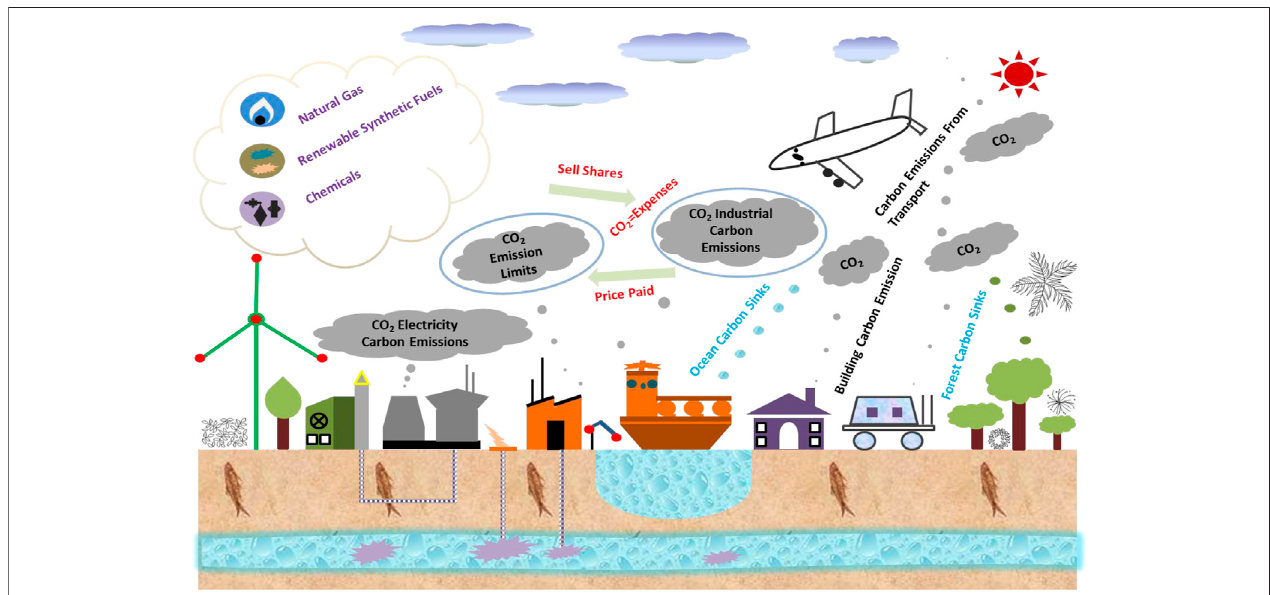
FIGURE 1 | Composition diagram of CCS and CCUS carbon industrial